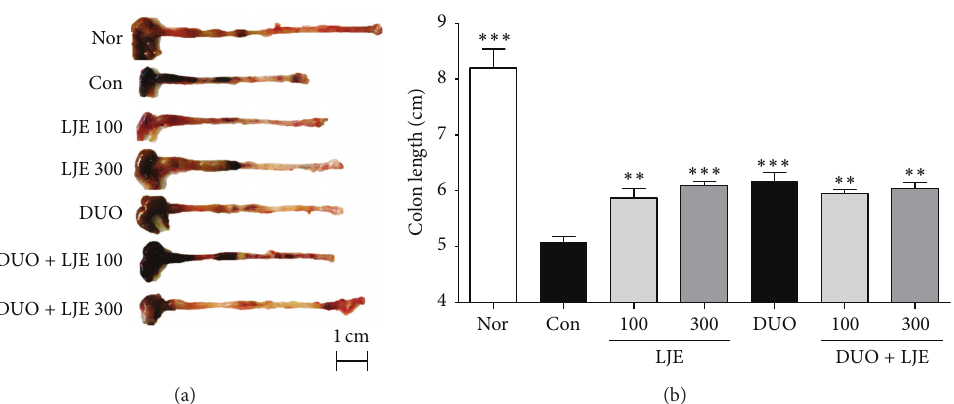
Figure 2: Effects of LJE or DUO on colon length in DSS-induced colitis. (a) The representative colon photos at 7 days on DSS-induced colitis, (b) a graph showing the data of colon length. Data are expressed as mean ± S.E.M ( 𝑛 = 7 ). Nor: normal mice without any treatment, Con: mice provided with only 5% DSS treatment, LJE: the water extract of Laminaria japonica , DUO: Duolac7S, LJE + DUO: cotreatment of LJE and DUO, 100: the dosage of LJE 100mg/kg, and 300: the dosage of LJE 300mg/kg; ∗∗ 𝑃 < 0.01 , ∗∗∗ 𝑃 < 0.001 versus control group analyzed by one-way ANOVA with Dunnett’s post hoc test.